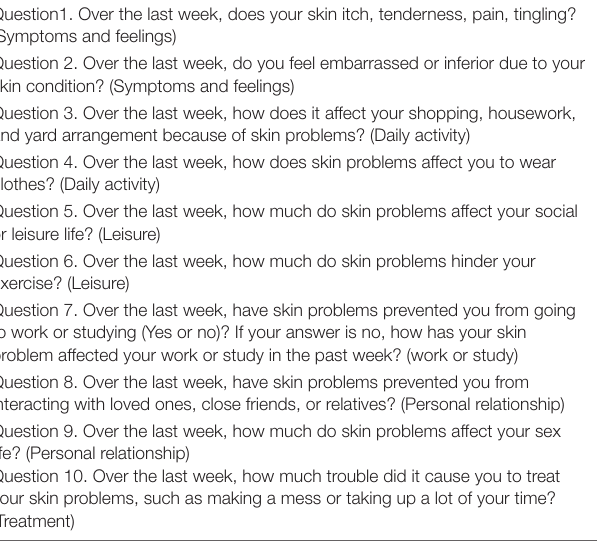
TABLE 1 | The dermatology life quality index questionnaire.